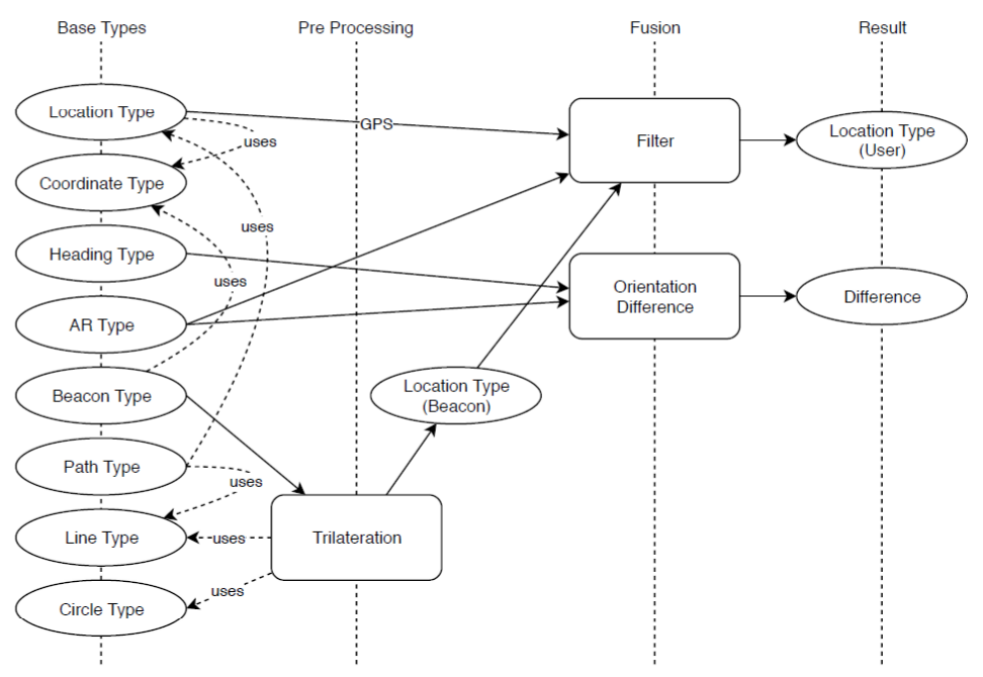
Figure 5. Overview of the